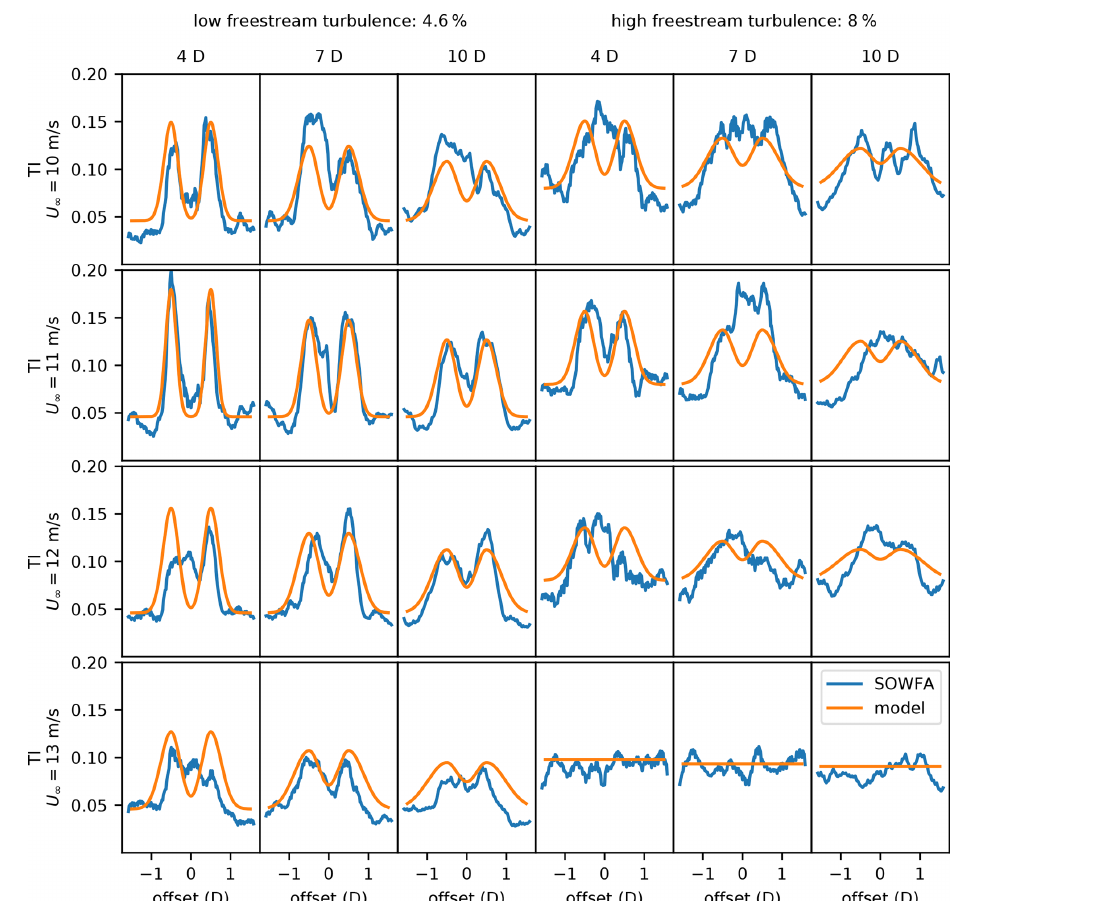
Figure 8. The turbulence intensity predicted by our large eddy simulation data compared to the analytic turbulence-intensity model for freestream turbulence intensities of 4.6% (three left columns) and 8% (three right columns). From left to right, each column represents the turbulence intensities at 4, 7, and 10 D downstream of the turbine generating the wake. From top to bottom, each row represents the turbulence intensities with a freestream wind speed of 10, 11, 12, and 13ms − 1